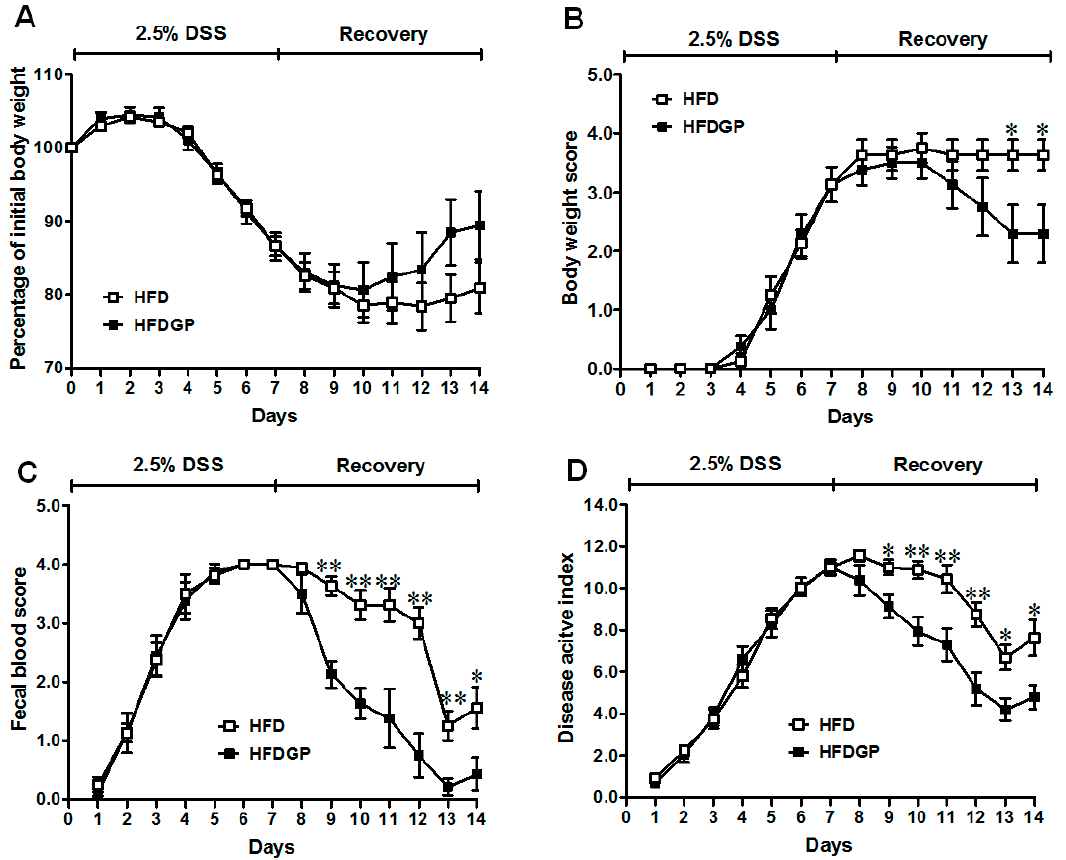
Figure 1. Symptoms of dextran sulfate sodium (DSS)-induced colitis in high-fat diet (HFD) ( □ ) or HFD supplemented with green pea (HFDGP) ( ■ ) fed mice. ( A ) Body weight loss; ( B ) Body weight loss score; ( C ) Fecal blood score; ( D ) Disease activity index score during DSS treatment and recovery process; a higher score correlates with severer symptoms. Means ± SEM, n = 7, * p ≤ 0.05, ** p ≤ 0.01.